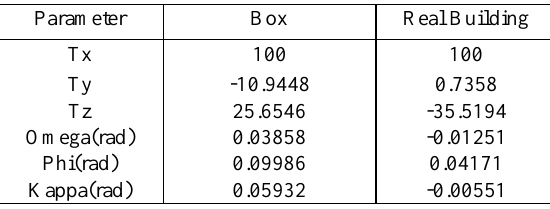
Table 1. Calculated relative orientation parameters